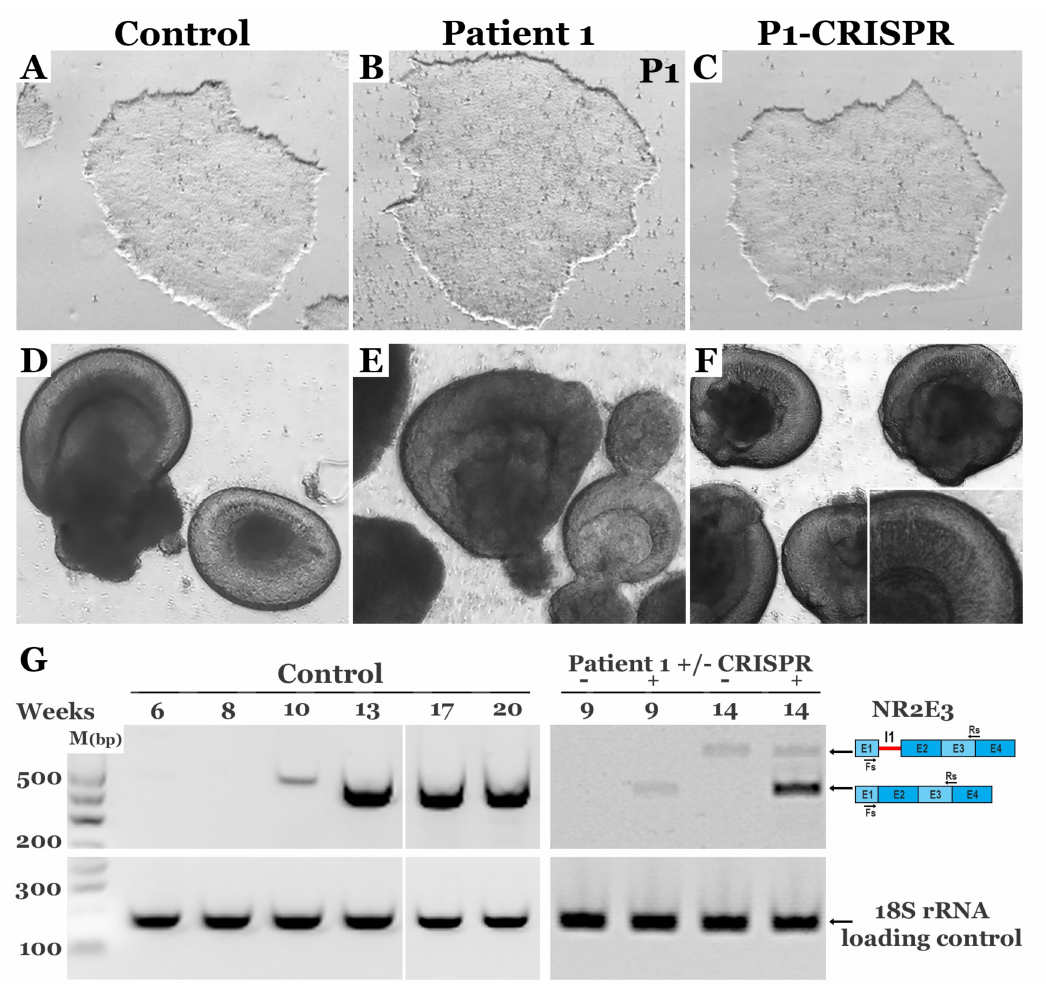
Figure 4. Correction of c.119-2A>C restores expression of normal NR2E3 transcript in patient-derived retinal cells. A–C : Bright-field images of control ( A ), Patient 1 ( B ) and CRISPR-corrected